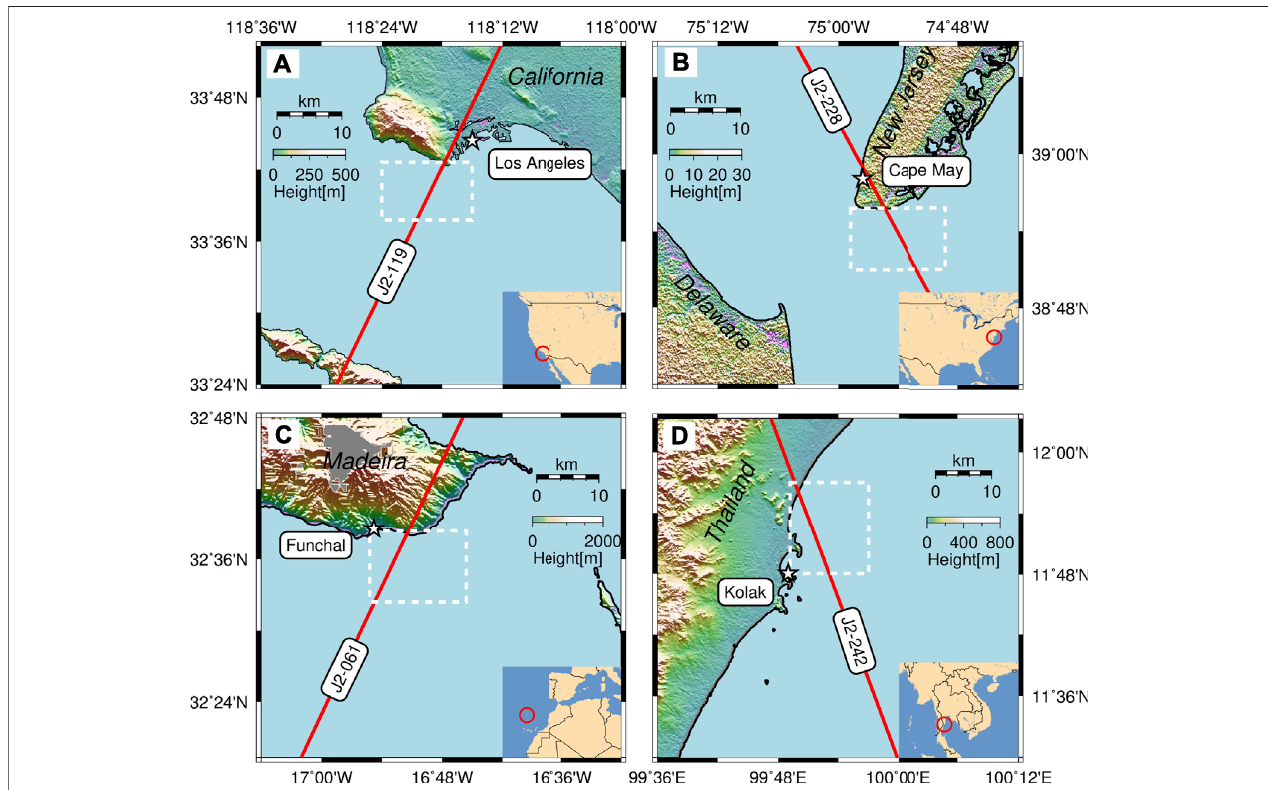
FIGURE 1 | Four areas for validation near tide gauge stations: (A) Los Angeles, California, United States; (B) Cape May, New Jersey, United States; (C) Funchal, Maderia Island, Portugal; (D) Ko Lak, Thailand. The red line denotes ground track of Jason-2. The white pentacle shows the position of tide gauge. The rectangle with white dashed line sketches the test